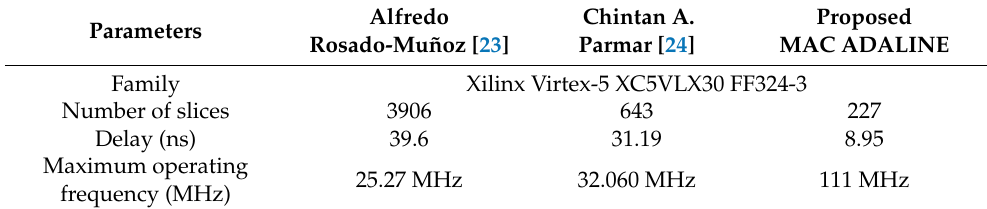
Table 6. Synthesis results of proposed MAC LMS filter with adaptive filter.